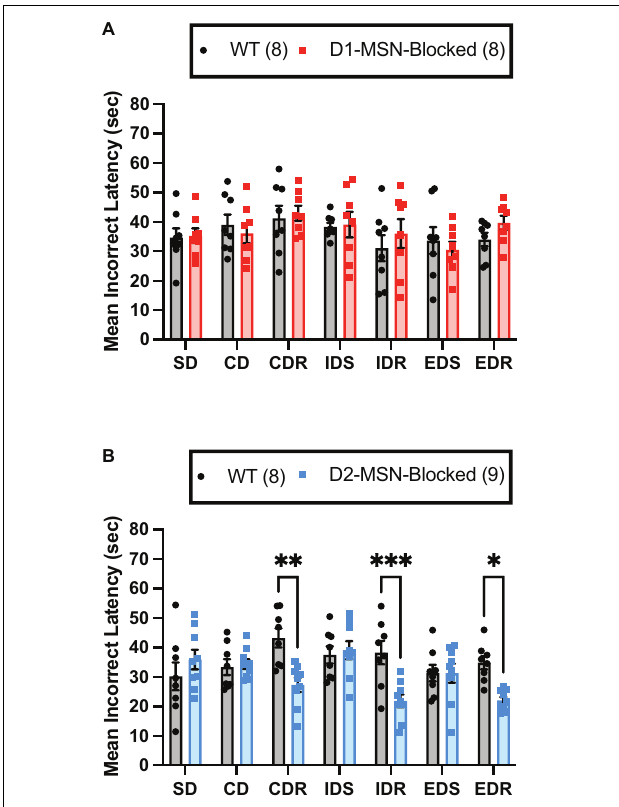
FIGURE 3 | NAc Core D2-MSN neurotransmitter release blockade reduces the latency to make response errors during reversal learning. NAc Core D1-MSN-Blocked ( n = 8) (A) and D2-MSN-Blocked ( n = 9) (B) mice did not differ from wildtype (WT) controls ( n = 8) in their mean latency to make response errors in discrimination (SD and CD) and set-shifting (IDS and EDS) stages of the attentional set-shifting task (ASST). However, neurotransmission release blockade in NAc Core D2-MSNs, but not D1-MSNs, resulted in a shorter latency to make response errors during reversal learning stages (CDR, IDR, and EDR) compared with WT controls. Bars represent mean ± SEM; Bonferroni post-hoc tests ( ∗ p < 0.05, ∗∗ p < 0.01, ∗∗∗ p <